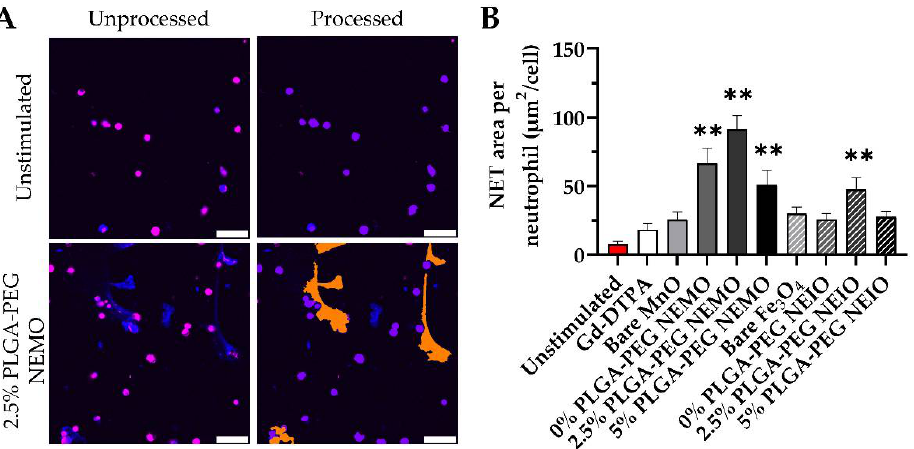
Figure 4. The fluorescence ex vivo NET assay demonstrates that NEMO particles elicit NETosis to a greater extent than NEIO particles. ( A ) Representative unprocessed and analyzed fluorescent ex vivo NET assay FOVs for unstimulated neutrophils and neutrophils stimulated with 2.5% PLGA-PEG NEMO particles are shown. The automated analysis of collected fluorescent NET assay images was utilized to define neutrophils and NETs in each FOV for every stimulation group. In the unprocessed images, Hoechst-33342 (DNA) staining is shown in blue, and CellTracker™ Deep Red (neutrophil) staining appears in pink. In the processed images, masks representing neutrophils are in purple and NETs in orange. Scale bar 50 µm. ( B ) The area of NETs per number of neutrophils was quantified and averaged for each stimulation group. The 2.5% PLGA-PEG NEMOs produced the most NETosis. ** indicates significance ( p < 0.01). The error bars represent standard error.